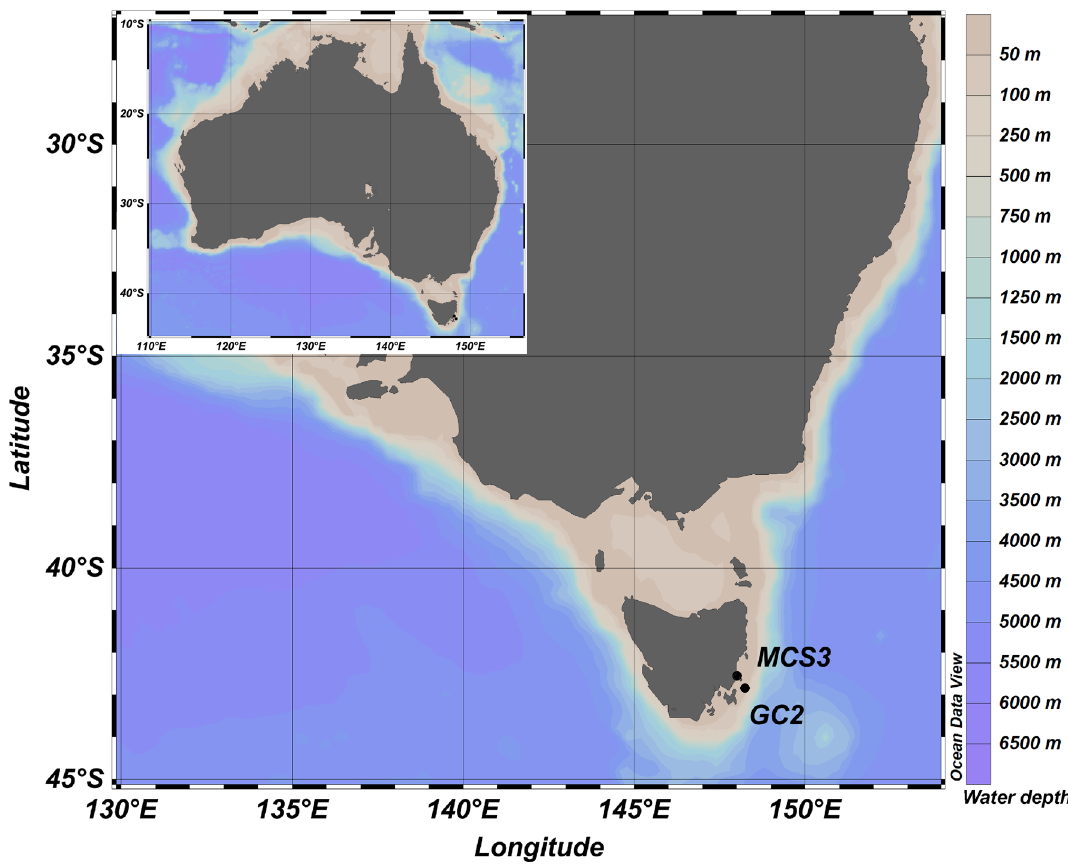
Figure 2. Map of coring sites, inshore (MCS3) and offshore (GC2) of Maria Island, Tasmania, South-East Australian Coast. Map created in ODV (Schlitzer, R., Ocean Data View, https ://odv.awi.de,